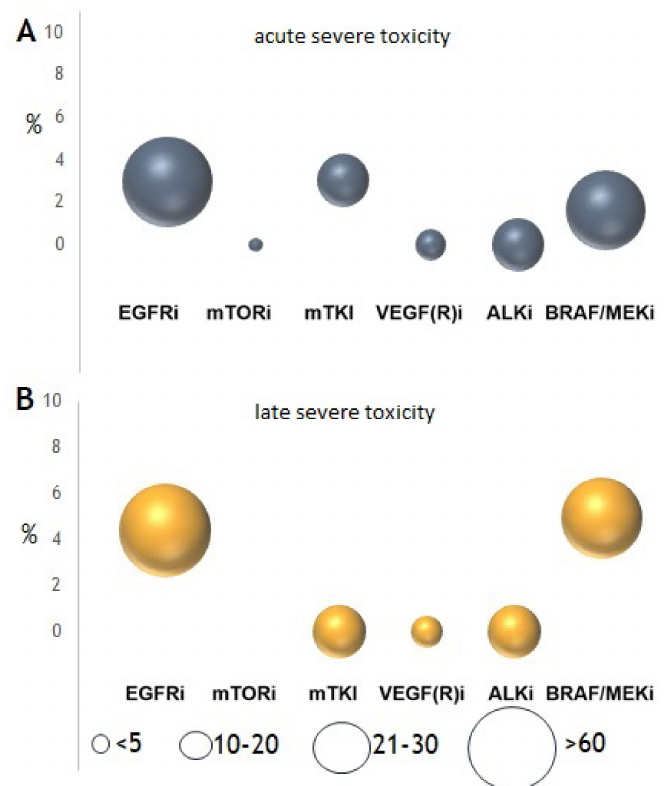
Figure 3. Observed ( A ) acute ( ≤ 3 months) and ( B ) late (>3 months) severe (CTCAE v4.03 ≥ G3)